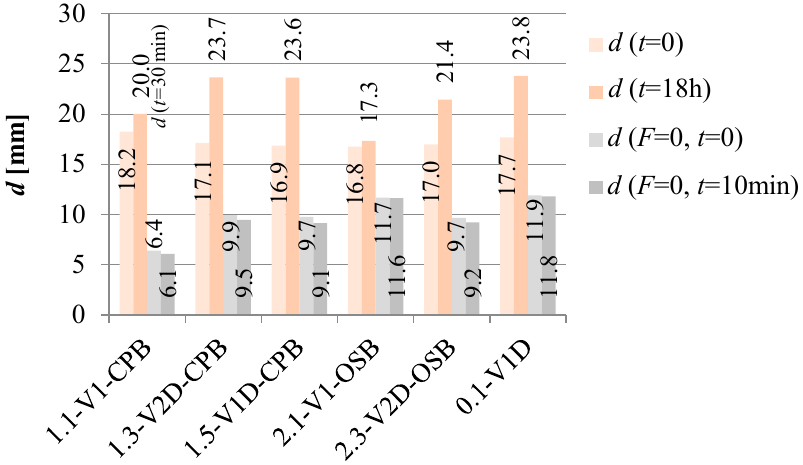
Figure 10. Beam vertical mid-span displacements at the beginning and the end of 18 h constant loading ( d ( t = 0) and d ( t = 18 h), respectively), after unloading d ( F = 0, t = 0), and after 10 min relaxation of the beams d ( F = 0, t = 10 min).